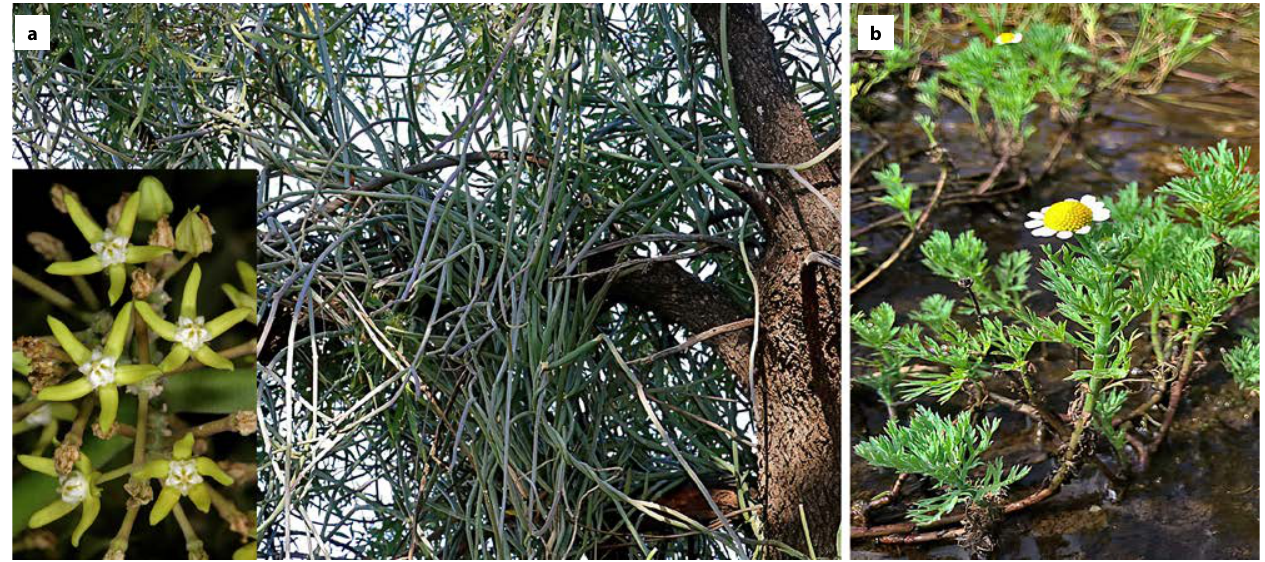
Figure 4: (a) Cynanchum viminale (= Sarcostemma viminale ) and (b) Cotula nigellifolia (= Matricaria nigellifolia ) Photographs: C.J. Botha (a, b) & A.E. van Wyk (insert a)